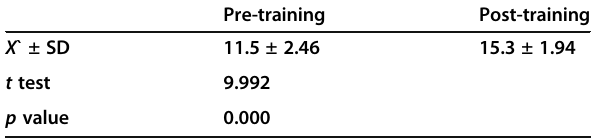
Table 3 Comparison of total mean scores between pre- and post-training results of dysgraphia disability scale ( N , 20 cases) (done by paired sample t